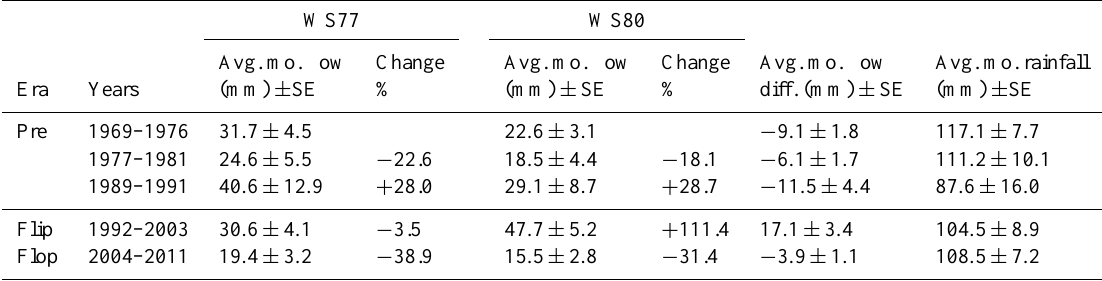
Fig. 7. Changes in rainfall, runoff and forest structure in WS77 and WS80 before (pre era) and after Hugo (flip and flop eras). Lower four panels show the number of all trees or only pine trees (lowest row) within a 1-ha plot. Tree diameters are scaled by a factor of 100. The sum of shaded areas in each watershed represents a consistently scaled approximation of basal area per hectare before (pre era) and after (flip era) Hugo. Refer to Table 2 for more details.